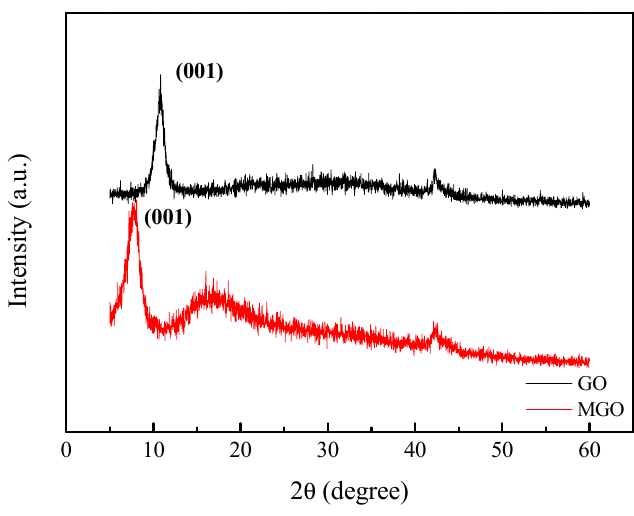
Figure 2. XRD spectra of GO and MGO.